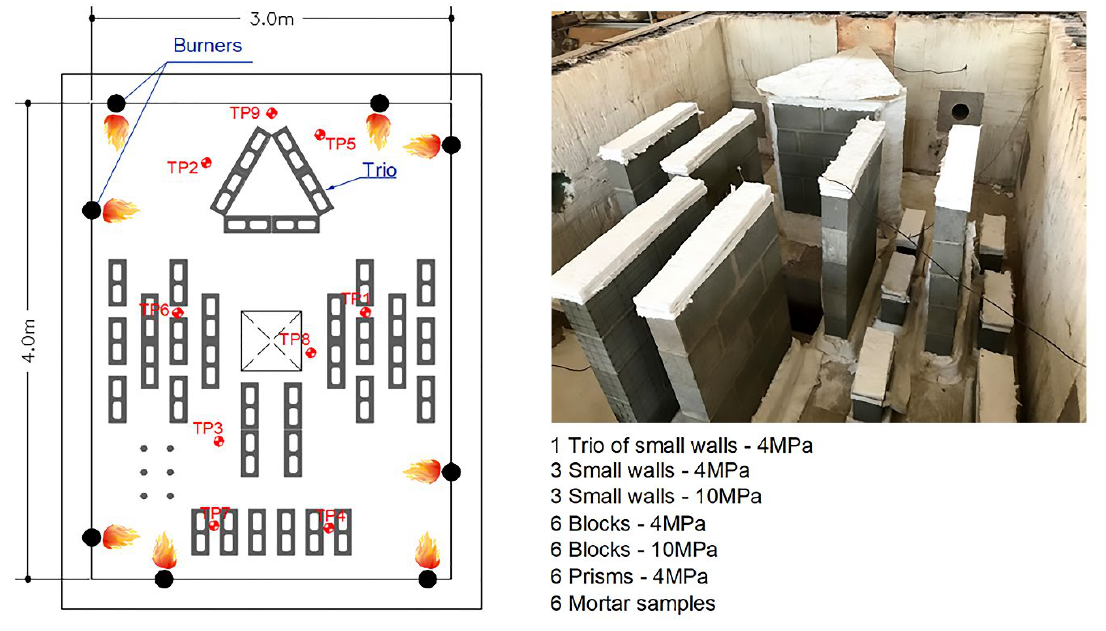
Figure 5. Test at elevated temperature: distribution of the specimens inside the